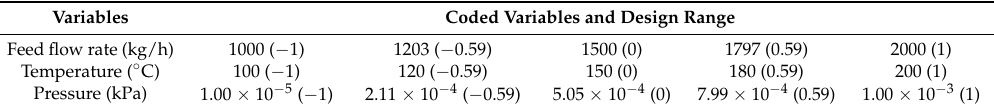
Table 7. Coded variables and design